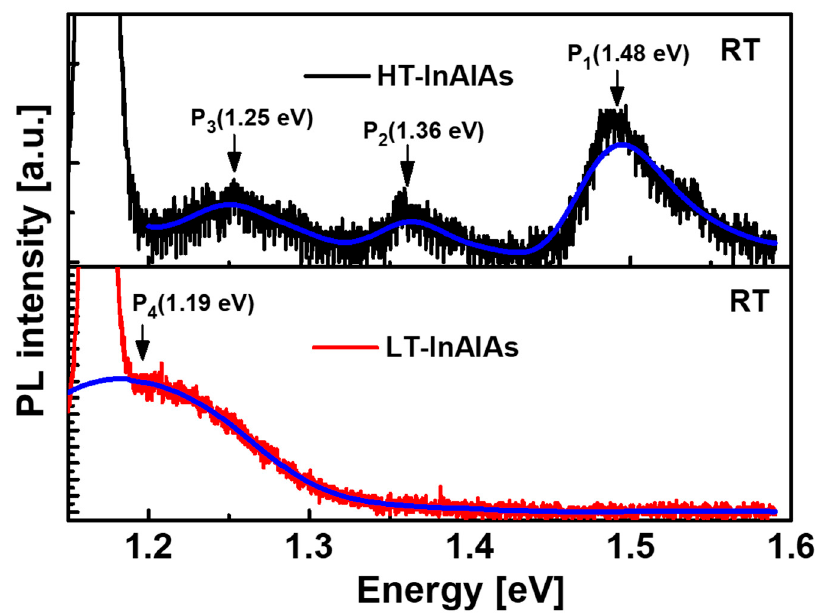
Figure 4. Room temperature PL spectrum for HT-InAlAs (top) and LT-InAlAs (bottom). The fitted spectra are drawn with blue lines.